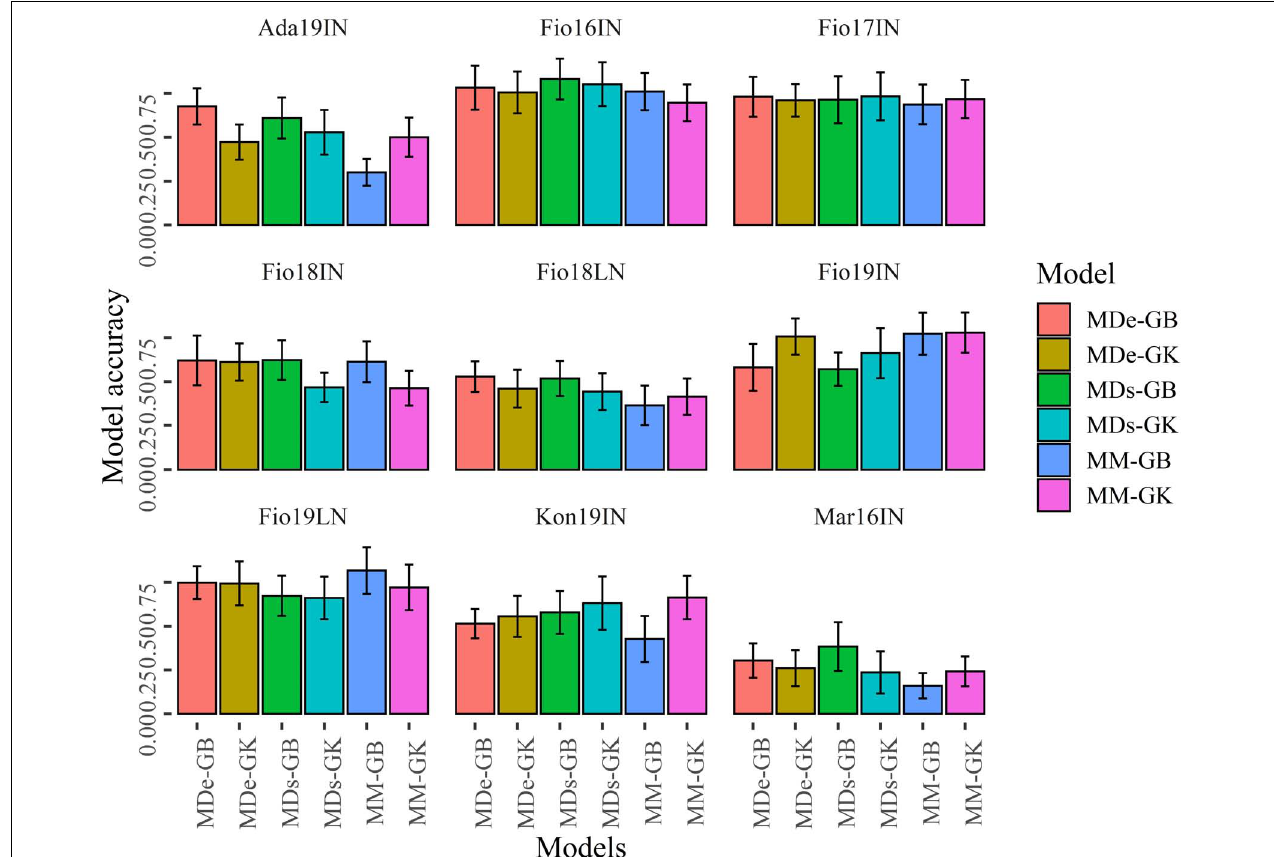
FIGURE 6 | Bar plots of the predictive ability values obtained with CV2. Bar plots show the mean correlation between observed and predicted values of GY obtained with 100 random CV2 partitions for MM, MDs and MDe models implemented with GBLUP (GB) and Gaussian Kernel (GK) methods. Error bars point out the standard deviation of predictive ability